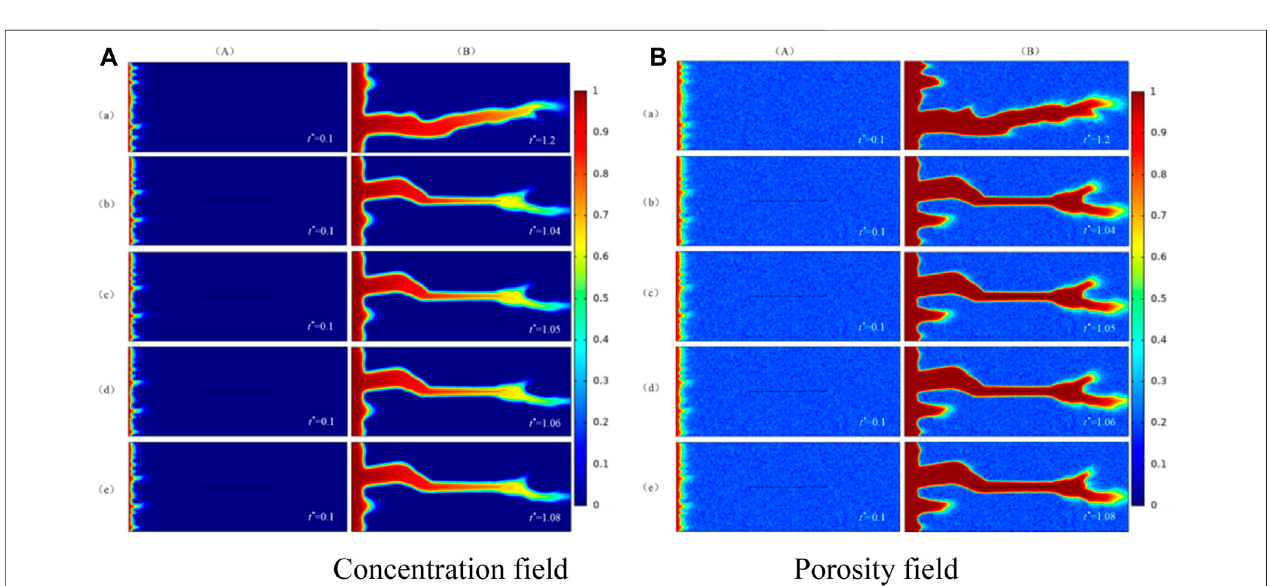
FIGURE7| Wormhole structure inthepresence ofdifferentfractureaperture.(a) No fracture; (b) b (cid:1) 5e-4 m; (c) b (cid:1) 1e-4 m; (d) b (cid:1) 5e-5 m; (e) b (cid:1) 1e-5 m; (A) The initial phase; (B) The dissolution structure when injected acid breaks through core.